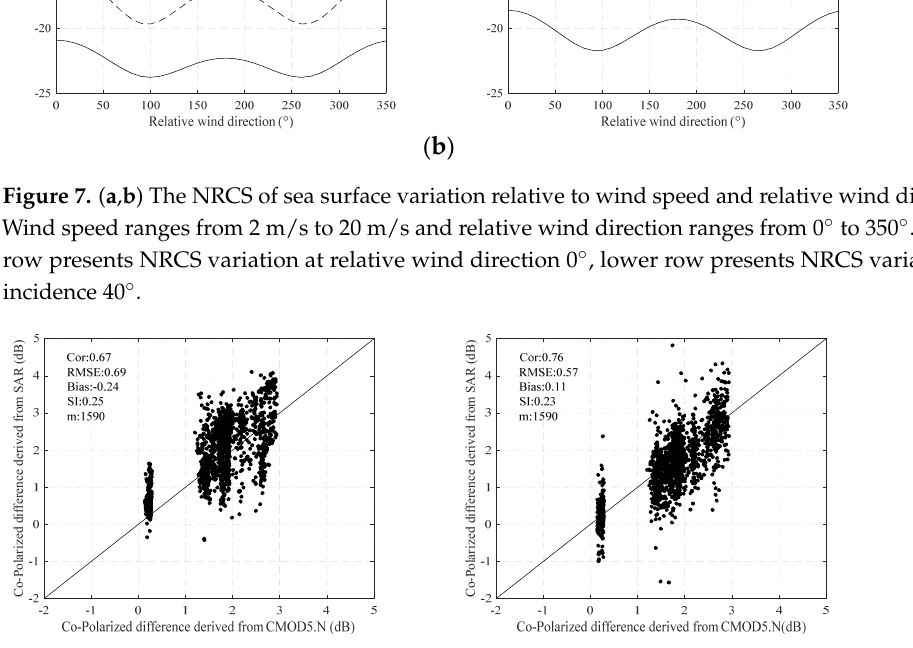
Figure 7. ( a , b ) The NRCS of sea surface variation relative to wind speed and relative wind direction. Wind speed ranges from 2 m/s to 20 m/s and relative wind direction ranges from 0° to 350°. Upper row presents NRCS variation at relative wind direction 0°, lower row presents NRCS variation at incidence 40°.